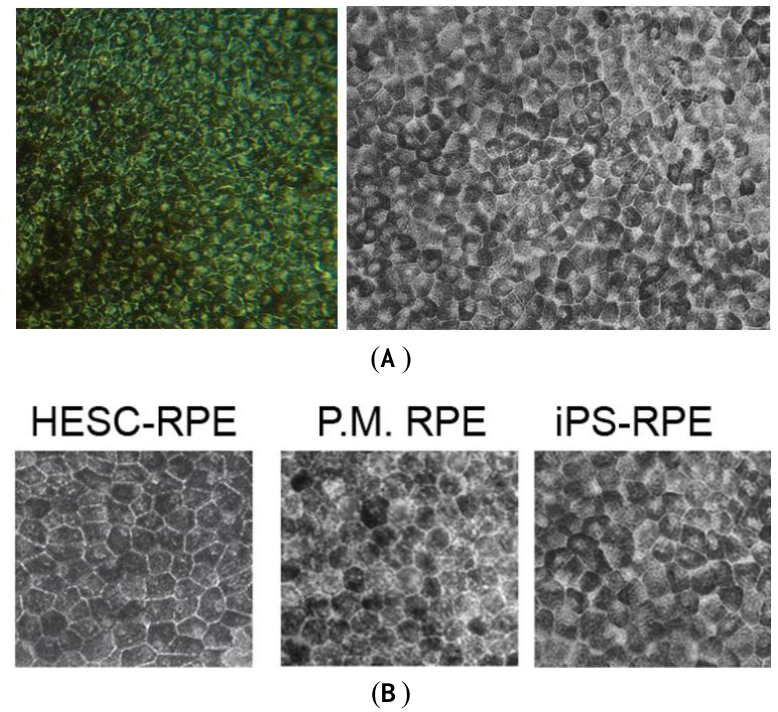
pigmented monolayer of retinal pigment epithelium derived from induced pluripotent stem cells; ( B ) Comparison of the morphology of retinal pigment epithelial stem cells derived from human embryonic stem cells (HESC), post-mortem (PM) eyes and induced pluripotent stem (iPS)